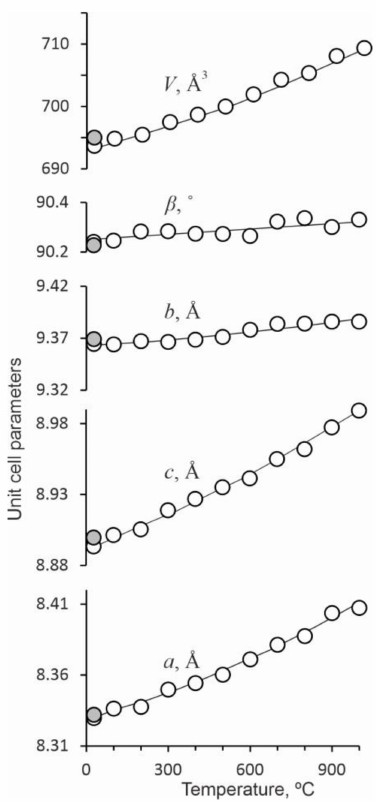
Figure 4. Unit-cell parameters ( a , b , c , β , V ) of slawsonite at different temperatures. The white symbols show the unit cell parameters on heating, the grey one – at room temperature after heating. The errors are smaller than the